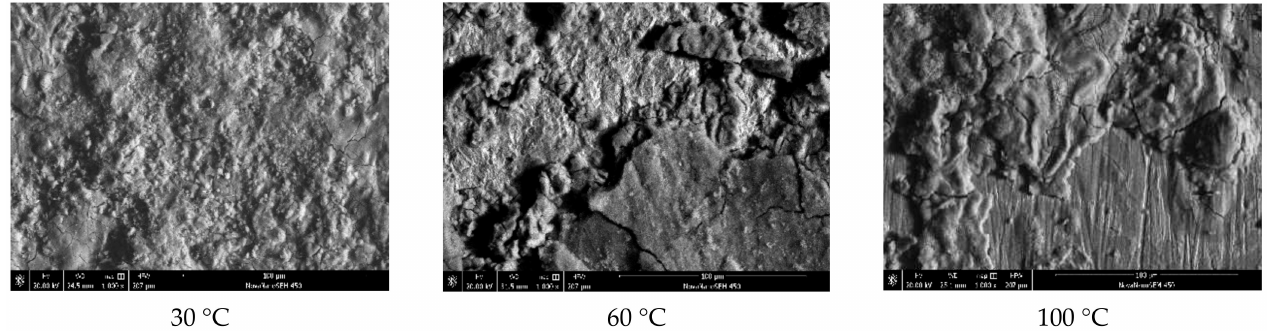
Figure 5. Surface microscopic corrosion profiles of 80S steel at different temperatures with a pressure of 32 MPa.